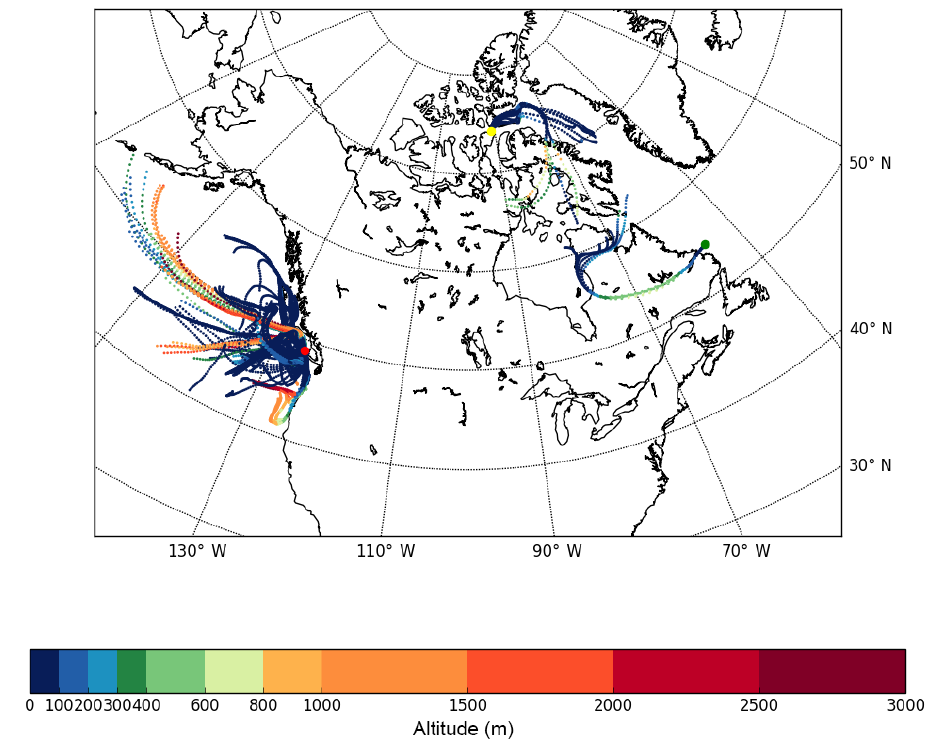
Figure 2. The 3-day HYSPLIT back trajectories for Amphitrite Point (red dot), Labrador Sea (green dot), and Lancaster Sound (yellow dot). The back trajectories were calculated for every hour during the MOUDI sampling period. The altitude is indicated with the colour scale. Global Data Assimilation System (GDAS) meteorological data at 1 ◦ × 1 ◦ spatial resolution were used as input to calculate the back trajectories using